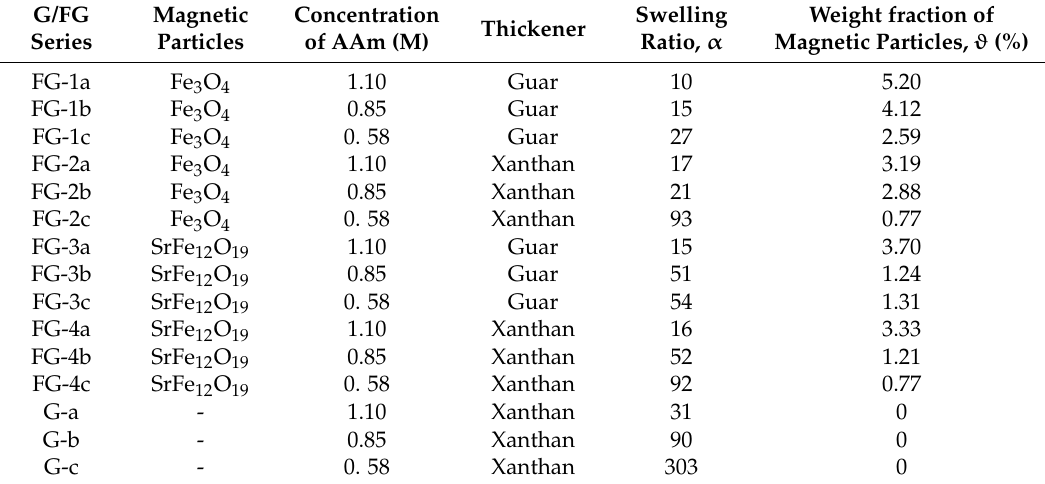
Table 1. Description of the synthesized gel and ferrogel samples: composition and swelling